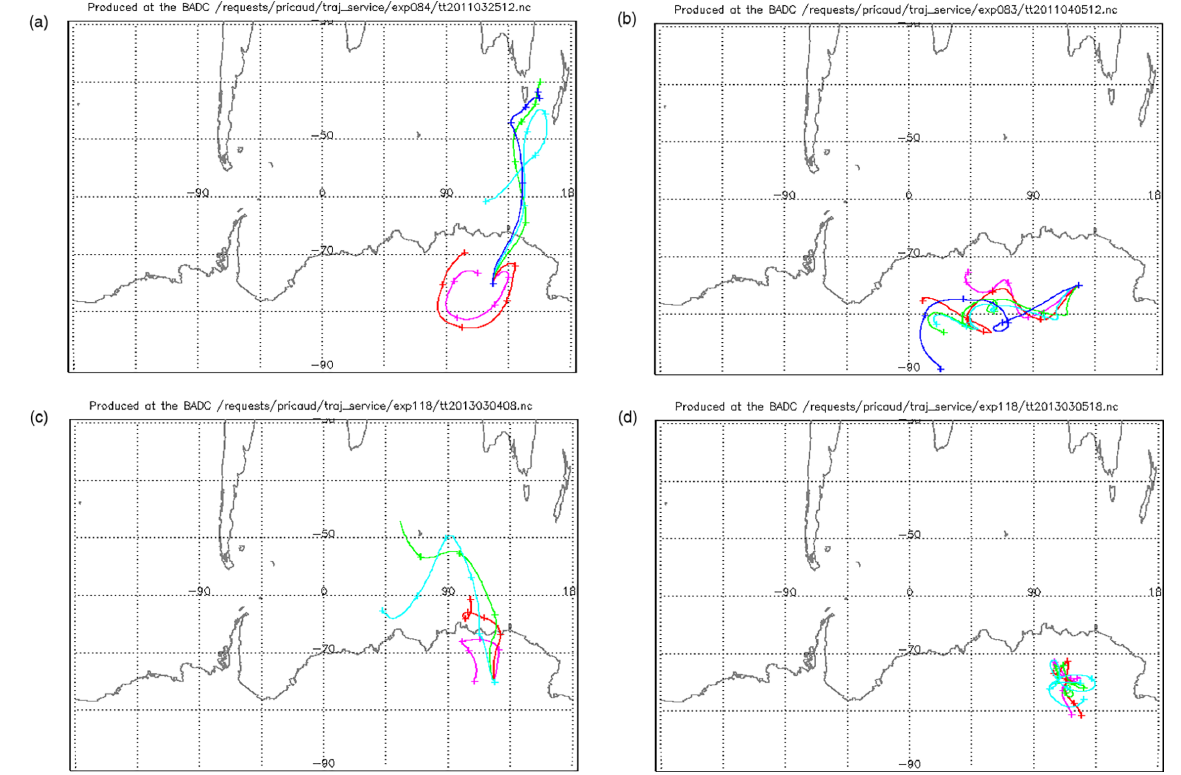
Figure 14. (a, b) Five-day back trajectories of air masses originated from Dome C on 25 March 2011 at 12:00UTC (a) and on 5 April 2011 at 12:00UTC (b) at 650 (pink line), 600 (red line), 500 (green line), 400 (light blue line) and 300hPa (dark blue line). (c, d) Same as (a, b) but on 4 March 2013 at 08:00UTC (c) and on 5 March 2013 at 18:00UTC (d)